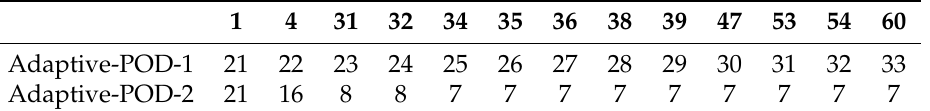
relative saturation error: fine and POD−DEIM for the system